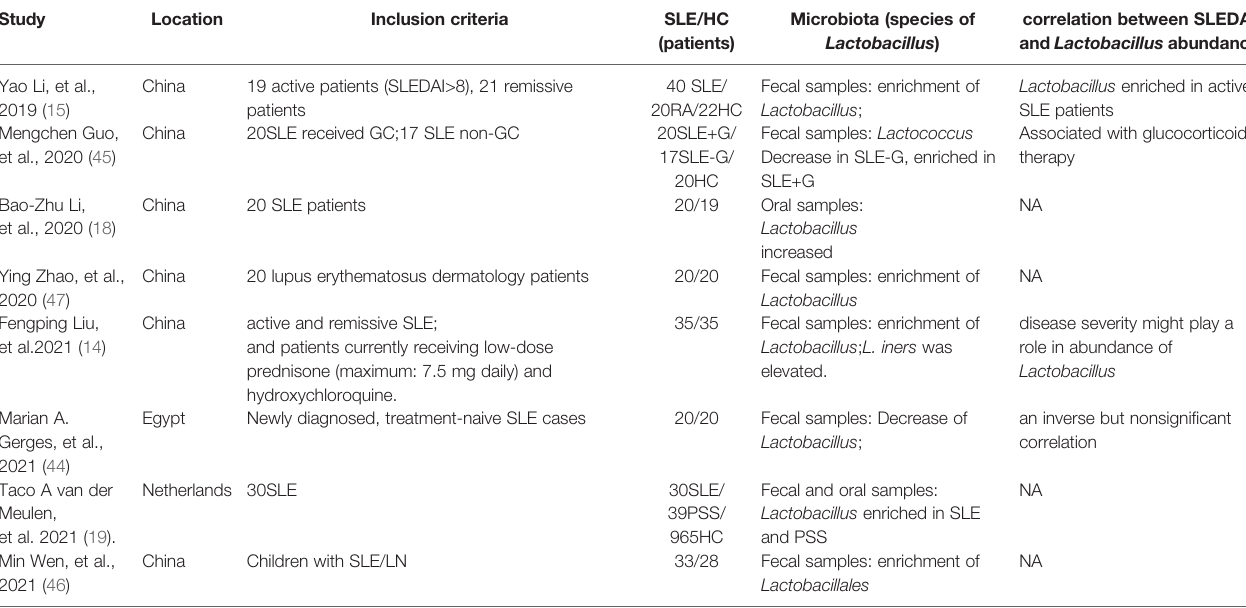
TABLE 1 | The cohort studies on Lactobacillus in SLE